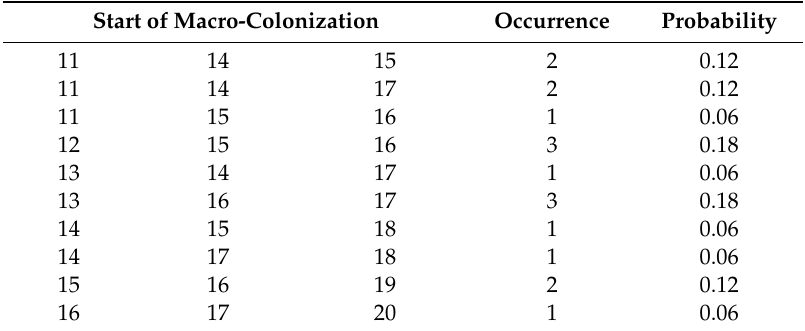
Table 2. Date of start of macro-colonization, expressed in 10 day periods, for three main spawning events of blue